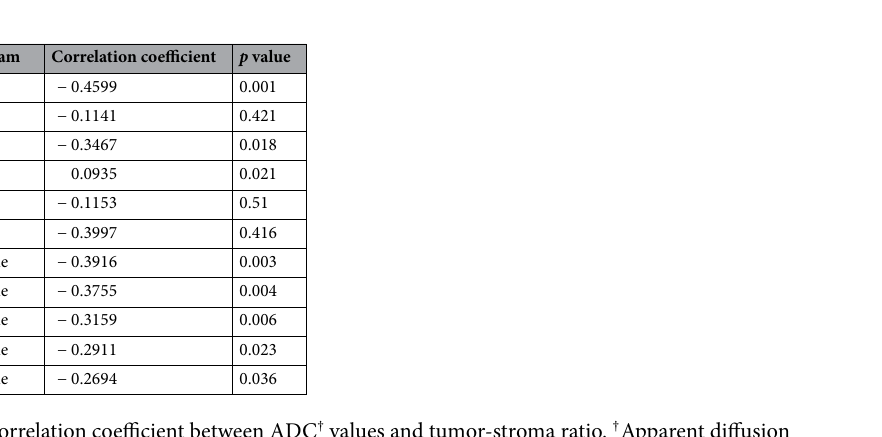
Table 3. Correlation coefficient between ADC † values and tumor-stroma ratio. † Apparent diffusion